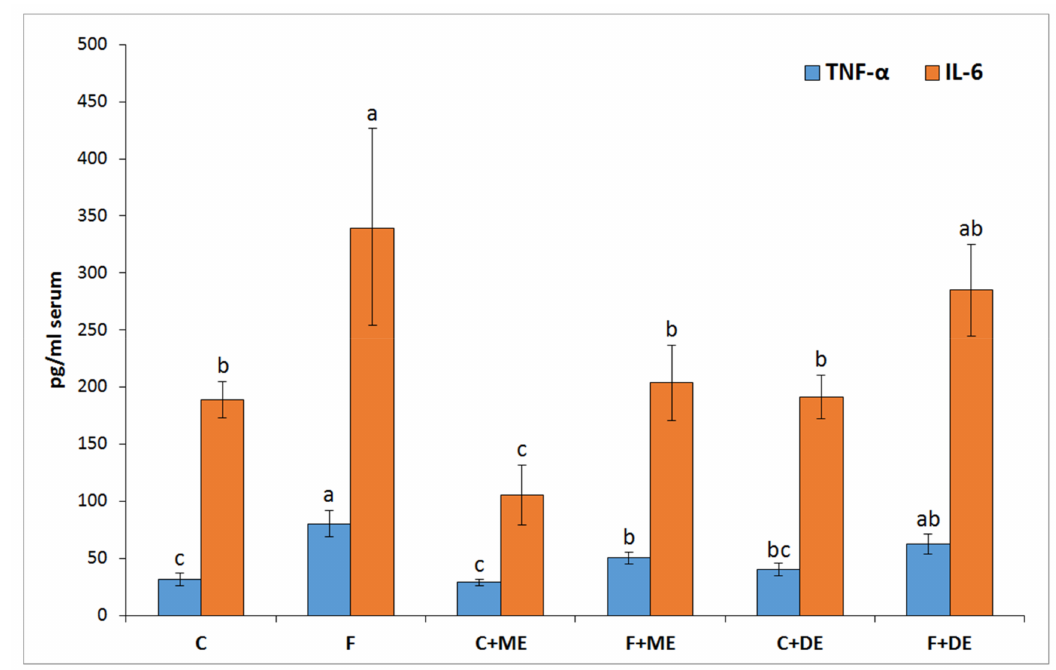
Figure 1. Pro-inflammatory cytokines in the blood serum of rats fed experimental diets. C, control fed a diet with 65.8% corn starch; F, fed a diet with 65.0% fructose (F) added at the expense of corn starch; C + ME, fed a corn starch-diet with a monomeric ET-rich extract; F + ME, fed a fructose-diet with a monomeric ET-rich extract; C + DE, fed a corn starch-diet with a dimeric ET-rich extract; F + DE, fed a fructose-diet with a dimeric ET-rich extract. a,b,c Mean values within a column with different superscript letters were shown to be significantly different ( p < 0.05). Tumor necrosis factor- α , (TNF- α ); Interleukin 6,